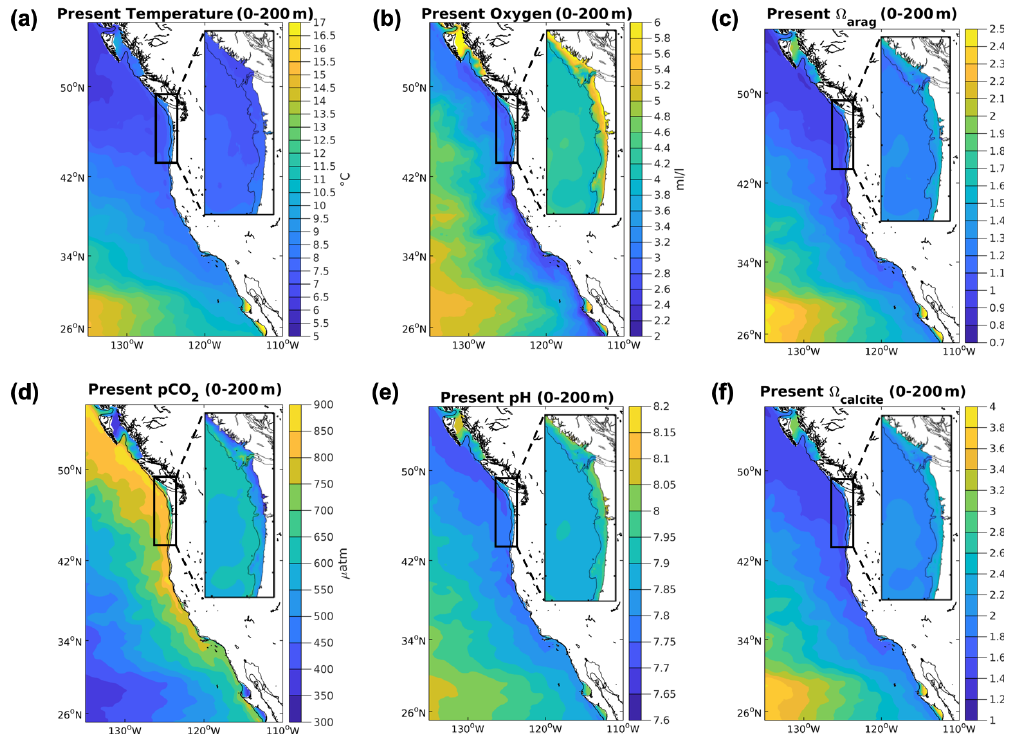
Figure 1. Base state climate stressor variables in the CCS in both domains. Depth-averaged over 200m values for the climate stressor variables in the base state/present conditions for the 12km (CCS-wide, full panel) and 1.5km simulations (N-CCS, inset) for (a) temperature ( ◦ C), (b) O 2 (mLL − 1 ), (c) (cid:127) arag , (d) p CO 2 (µatm), (e) pH, and (f) (cid:127) calcite